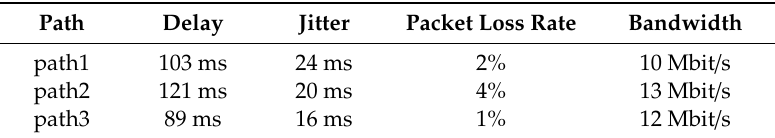
Table 3. The QoS information of the three